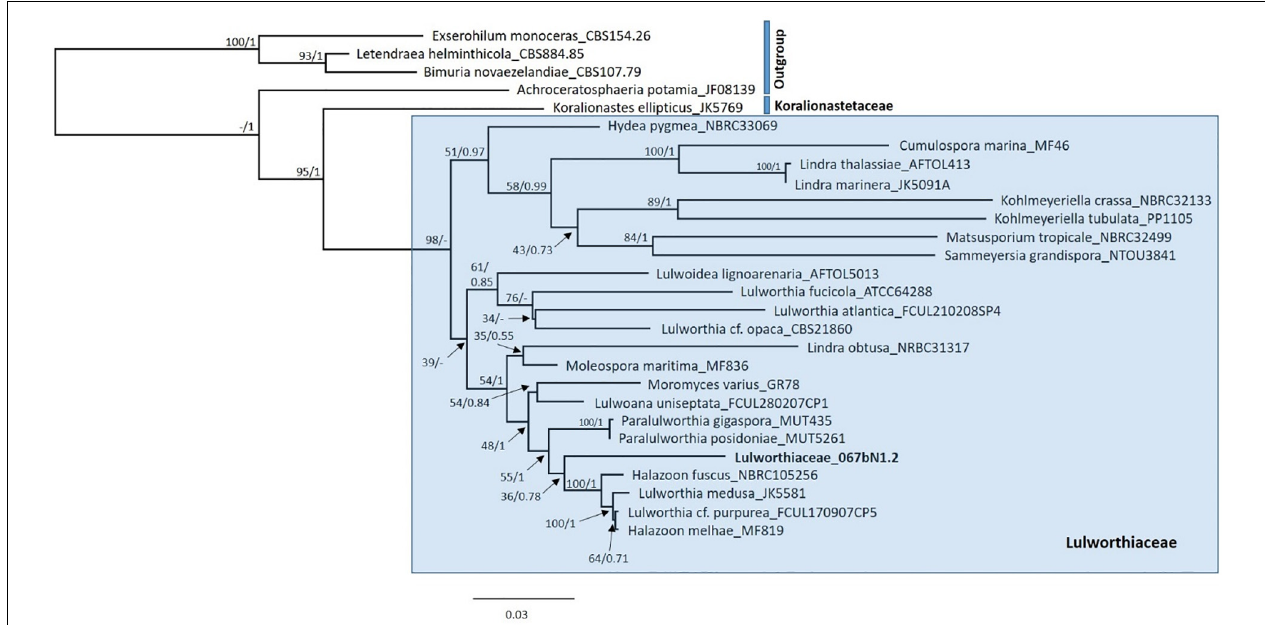
FIGURE 1 | Maximum Likelihood tree (RAxML) from the combined analysis of 5.8S, SSU, and LSU from isolates of Lulworthiaceae. One isolate from Koralionastetaceae was included, and four strains as outgroups. Node support is given as Bootstrap support values at the nodes, and posterior probabilities are included where the branching was alike (BS/PP). The isolate under investigation, Lulwortihaceae_067bN1.2, is highlighted in bold. Due to topological similarity only the ML tree is shown here containing both Bayesian posterior probabilities and Bootstrap support values. Bayesian Inference tree can be found in Supplementary Figure 1 . – indicates that the node is missing in the Bayesian analysis. No support value is given to the node separating the outgroup taxa from the ingroup in ML analysis.